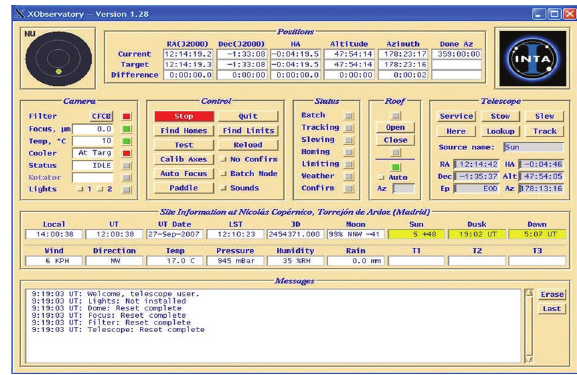
Figure 9: Talon graphical user interface for telescope